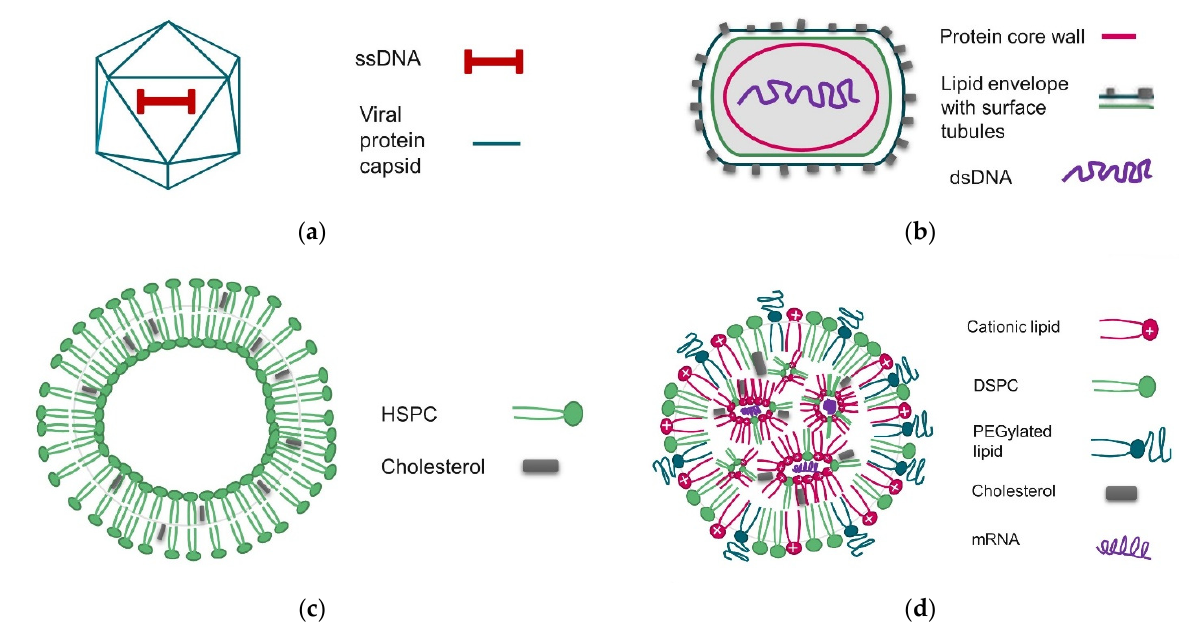
Figure 1. Schematic representation of the basic structures and compositions of nanoparticles characterized in this study. ( a ) rAAV, ( b ) MVA virus, ( c ) HSPC/CHOL liposome, ( d ) mRNA-LNP. Table 3. Viral and non-viral delivery vectors used in this study.